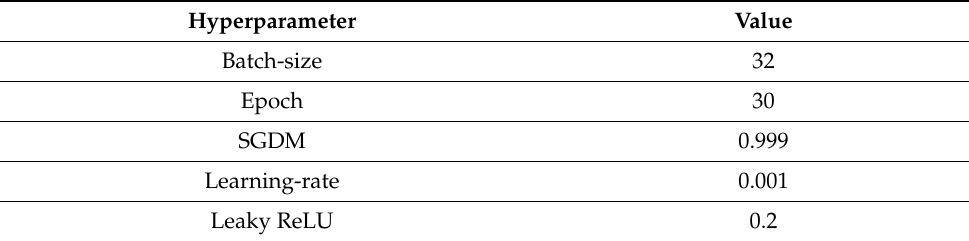
Table 7. Hyperparameter settings of S-ResNet classification model.